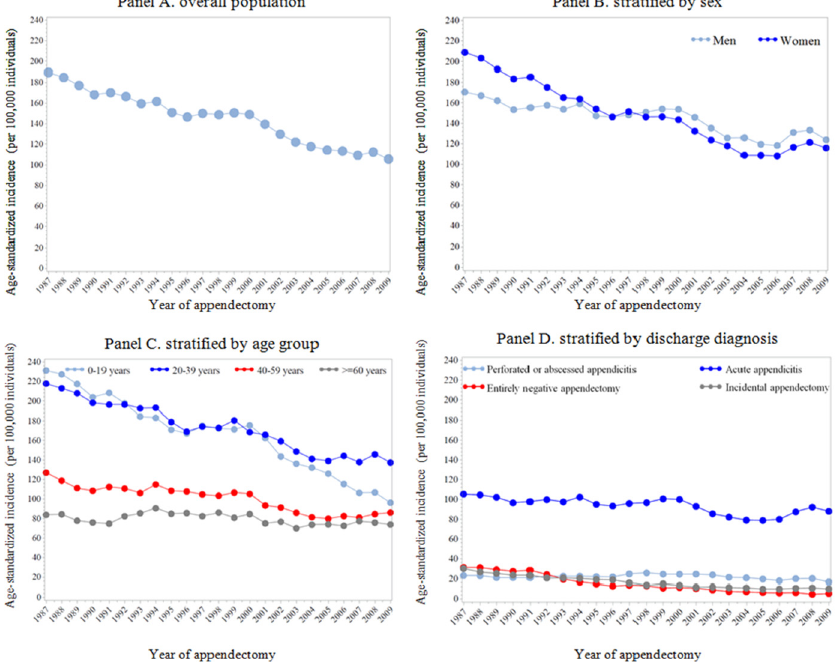
Fig 1. The age-standardized incidence of appendectomy in Sweden, during 1987 – 2009 (n = 269,185). Panel A. the age-standardized incidence of appendectomy over years among overall population; Panel B. the age-standardized incidence of appendectomy over years, stratified by sex; Panel C. the age-standardized incidence of appendectomy over years, stratified by age group; Panel D. the age-standardized incidence of appendectomy over years, stratified by discharge